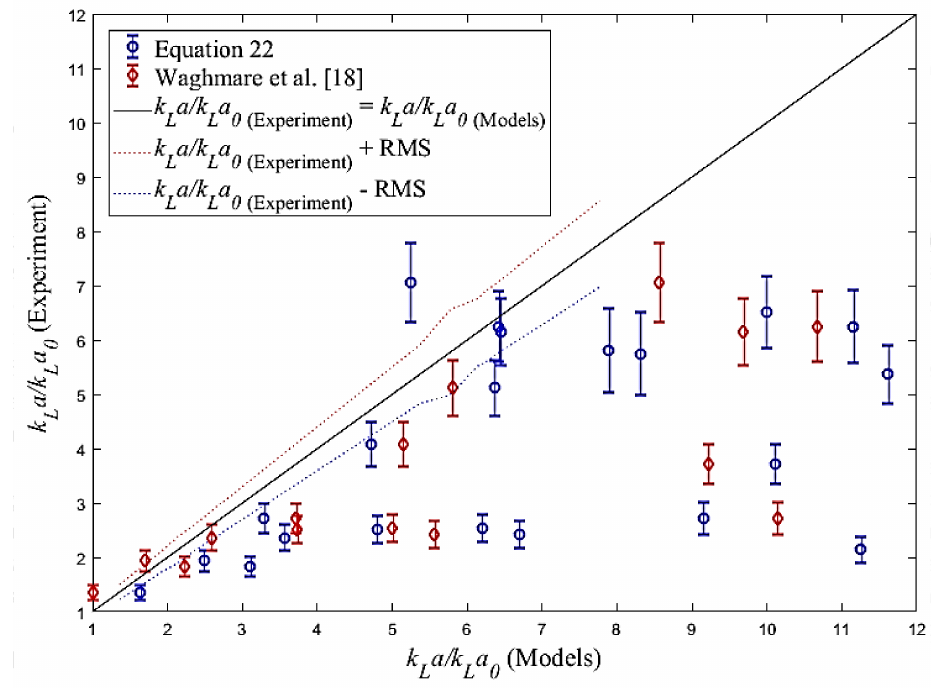
Figure 17. Comparison of the experimental data with the predicted k L a / k L a 0 by models from this work and Waghmare et al. [18]. RMS is the root mean square of k L a / k L a 0